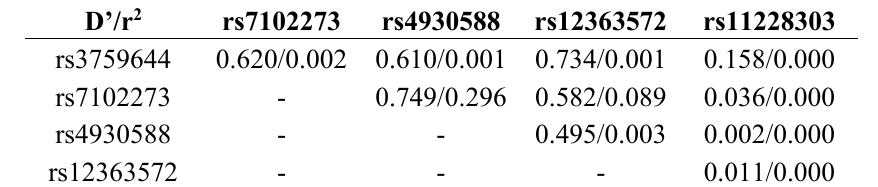
Table 13. The linkage disequilibrium (as D’/r2) between SNPs of LRP5 gene in the Chinese population.